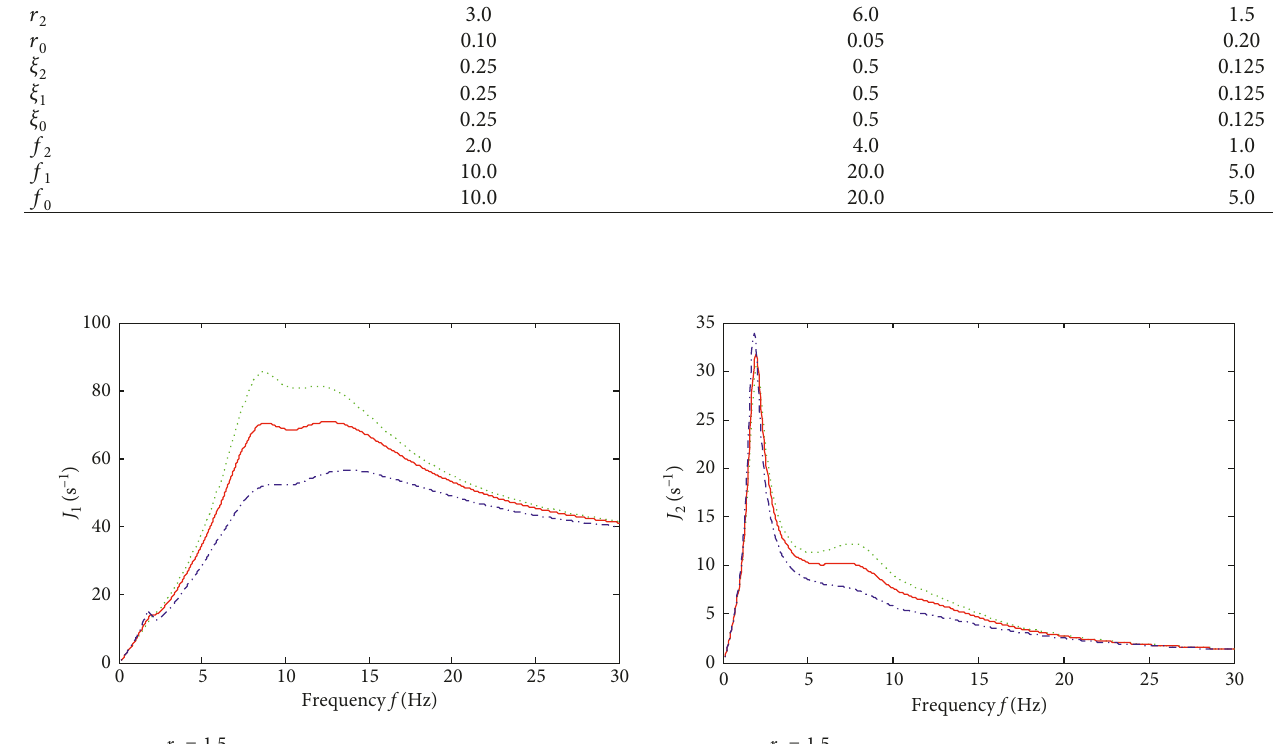
on € z , € z , and f : (a) the amplitude frequency characteristics J 2 1 2 d at different values of r ; (c) the amplitude frequency characteristics J 2 2